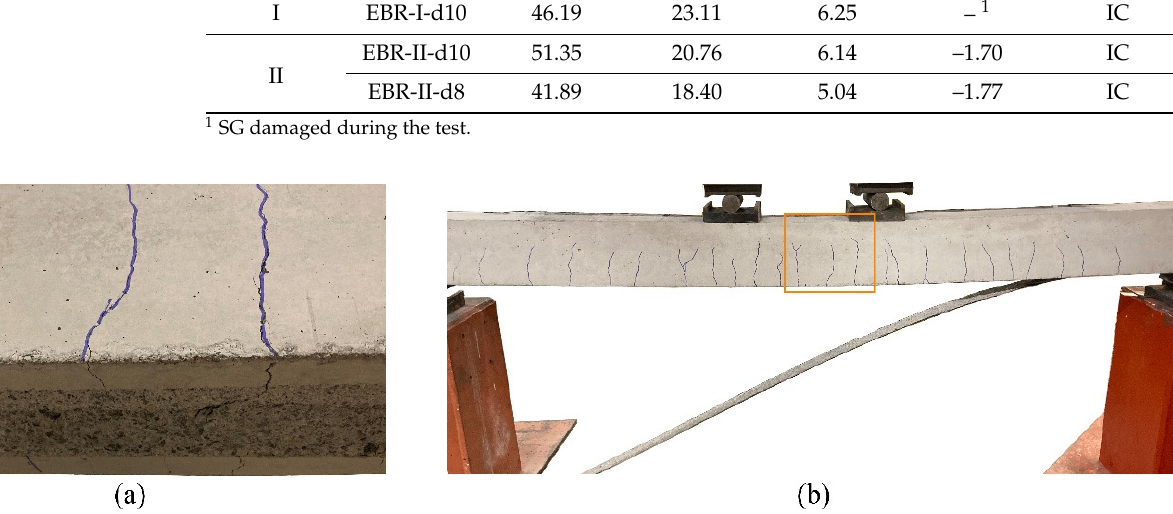
Figure 6. Failure of beam EBR-I-d10: ( a ) Failure surface and ( b ) ICD failure and crack pattern.